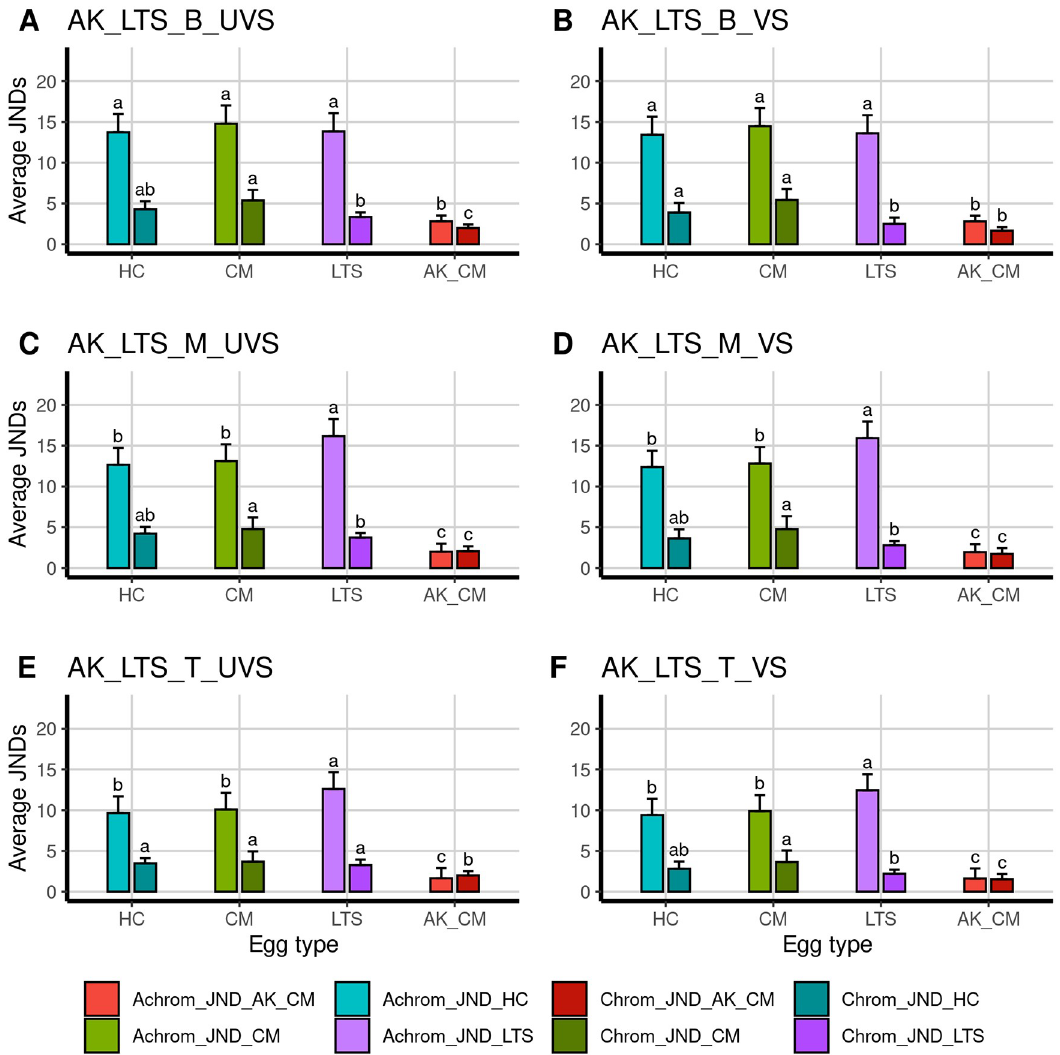
Fig 5. Average achromatic and chromatic JNDs ± SD between Asian koel eggs laid in long-tailed shrike nests compared to three hosts: The house crow (HC), the common myna (CM) and the long-tailed shrike (LTS) and the eggs of the Asian koel laid in common myna nests (AK_CM). Achromatic (Achrom_JND) and chromatic (Chrom_JND) analyses were performed for each egg region (B = blunt, M = middle, T = top) and visual system (UVS = ultraviolet-sensitive, VS = violet-sensitive), separately. Letters above columns denote significant differences (Dunn post-hoc test, p < 0.05 after accounting for multiple tests following Benjamini and Hochberg 1995 [94], see supplement for tests S4